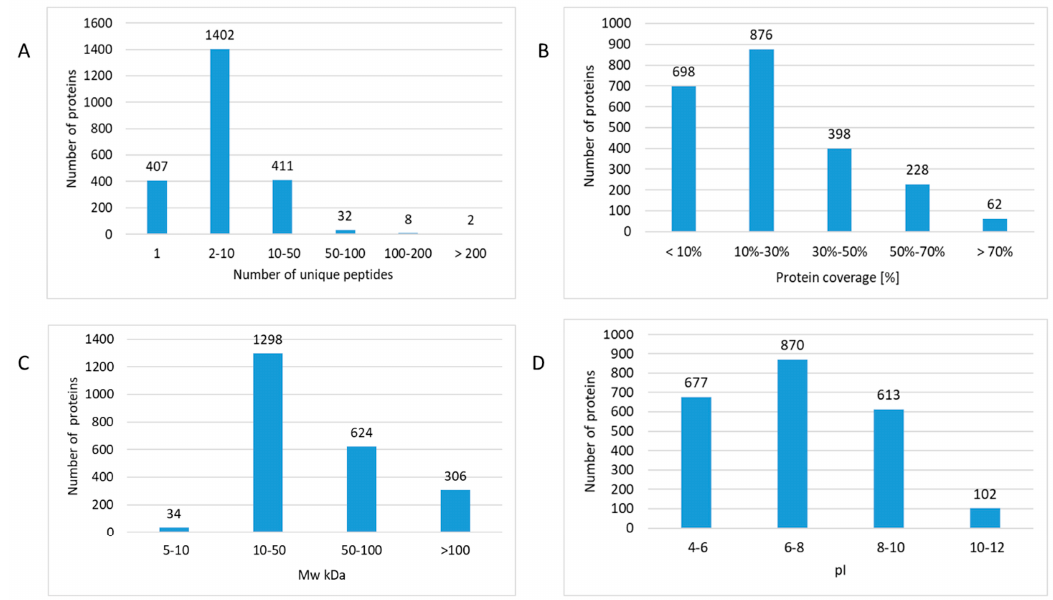
Figure 2. The features of protein identifications in formalin-fixed paraffin-embedded (FFPE) proteomics. The number of identified proteins was assigned based on the number of unique peptides ( A ), protein coverage ( B ), molecular weight (MW kDa) ( C ), and isoelectric point (pI) ( D ). The analysis was performed using the Proteome Discoverer 2.3 software (Thermo Scientific, Waltham, MA, USA). Detailed information of the proteomics features is given in Table S2.